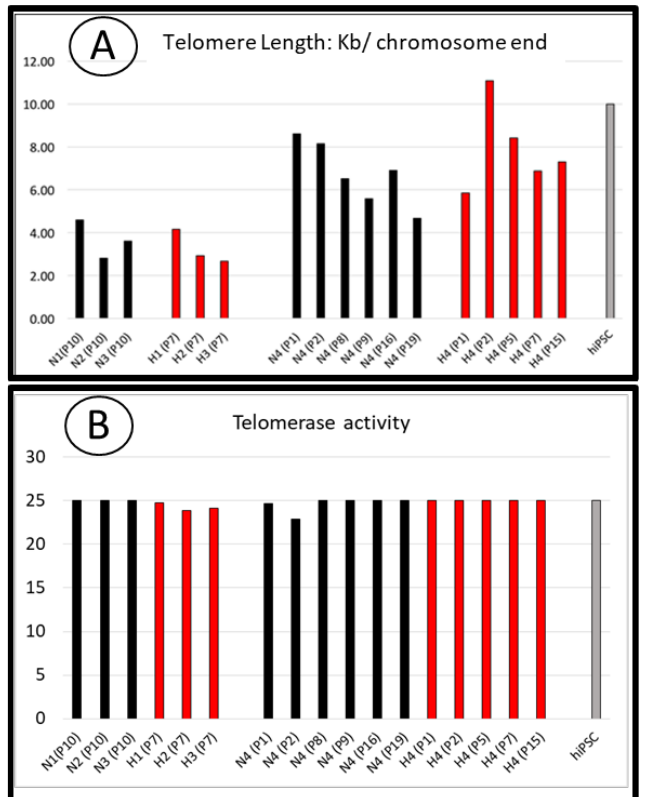
Figure 4. Telomere length and telomerase activity in SCAPs grown at different O 2 concentrations. ( A ) Telomere length of SCAPs from three donors (N1 to N3) at passages (P) which correspond to similar cumulative population doubling (25 DPC) and for the donor 4 at different passages as indicated, N (21% O 2 ) and H (3% O 2 ). The hiPSC cell line (established from IMR90 fibroblasts, Passage 35) is included as a positive control of a highly proliferative cell line. ( B ) Telomerase activity on same cell samples as in A).